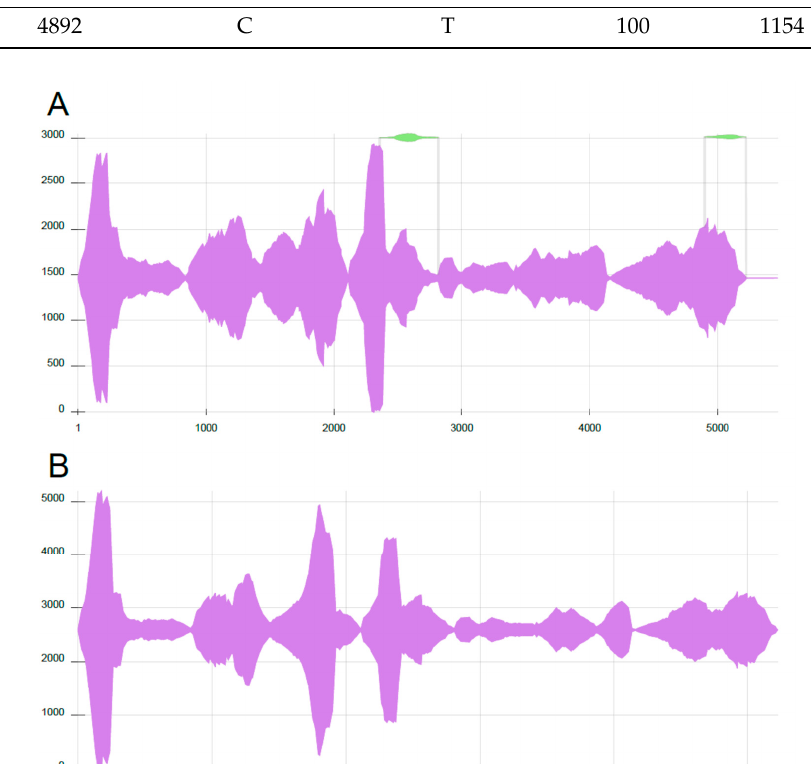
Figure 2. Clonal analysis revealed heterogeneous viral populations in LRV2-Lmj-Uzb1. Nucleotide positions are on the X axis, the Y axis serves as a ruler in the Sankey graph and represents depth